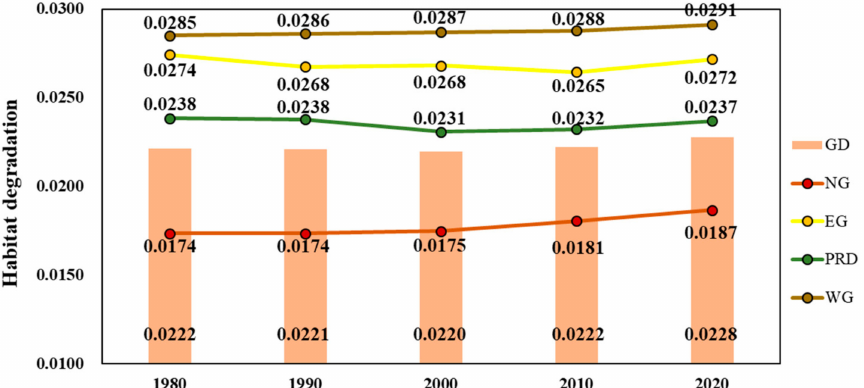
Figure 7. The habitat quality change ( a ) and its hotspots distribution ( b ) from 1980 to 2020. (Note: 99% Confidence refers to at the 99% significant level; 95% Confidence refers to at the 95% significant level; 90% Confidence refers to at the 90% significant level).